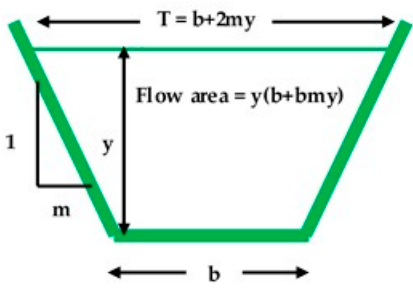
Figure A1. Design of Trapezoidal detention basin Table A1. Design parameters of detention basin for two drainage systems. Conventional Drainage System Hybrid Drainage System